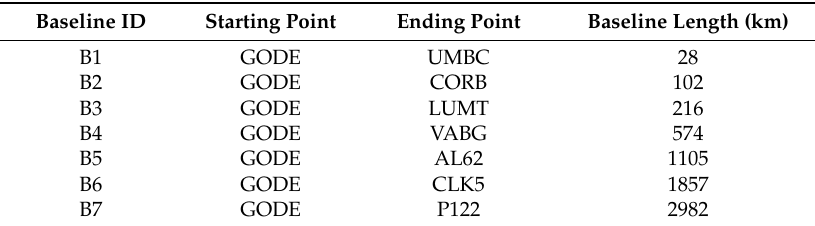
Table 3. Baseline information.